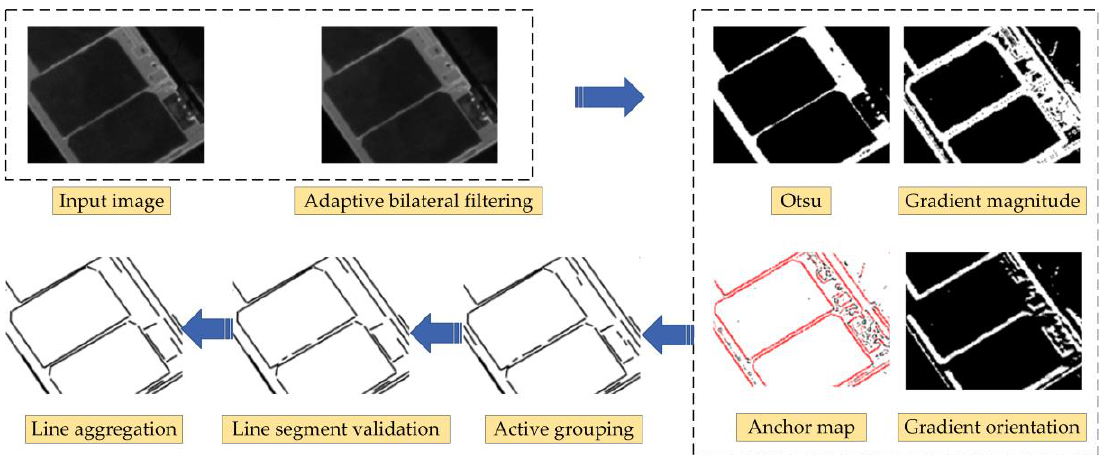
Figure 2. The workflow of